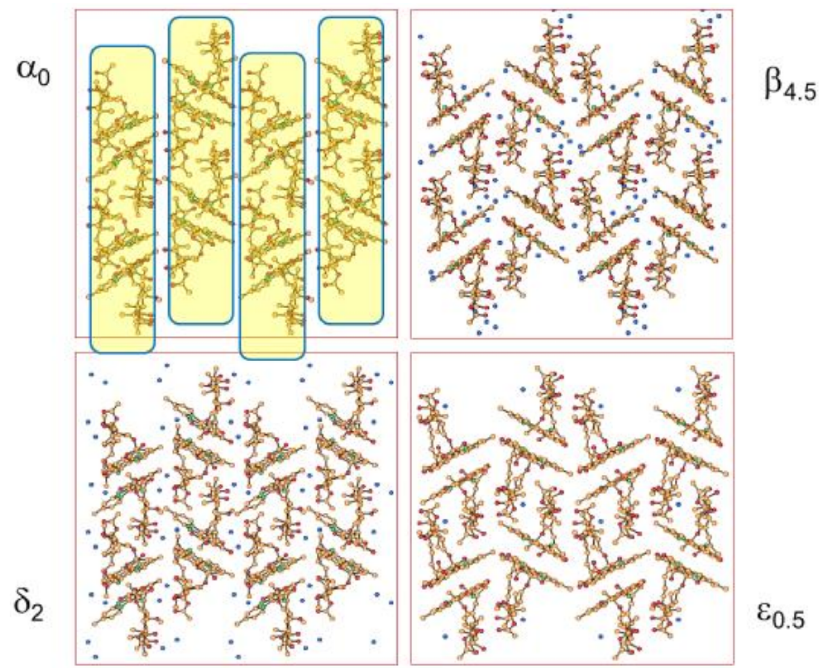
Figure 19. A comparison of molecular packings in four hydrate forms of the antibiotic Rifaximin. Reproduced with permission from [63].